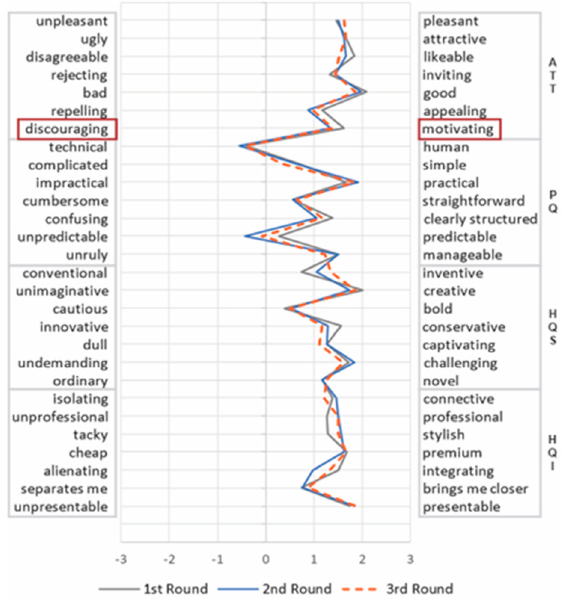
Figure 4. Variation of AttrakDiff evaluated items over time.